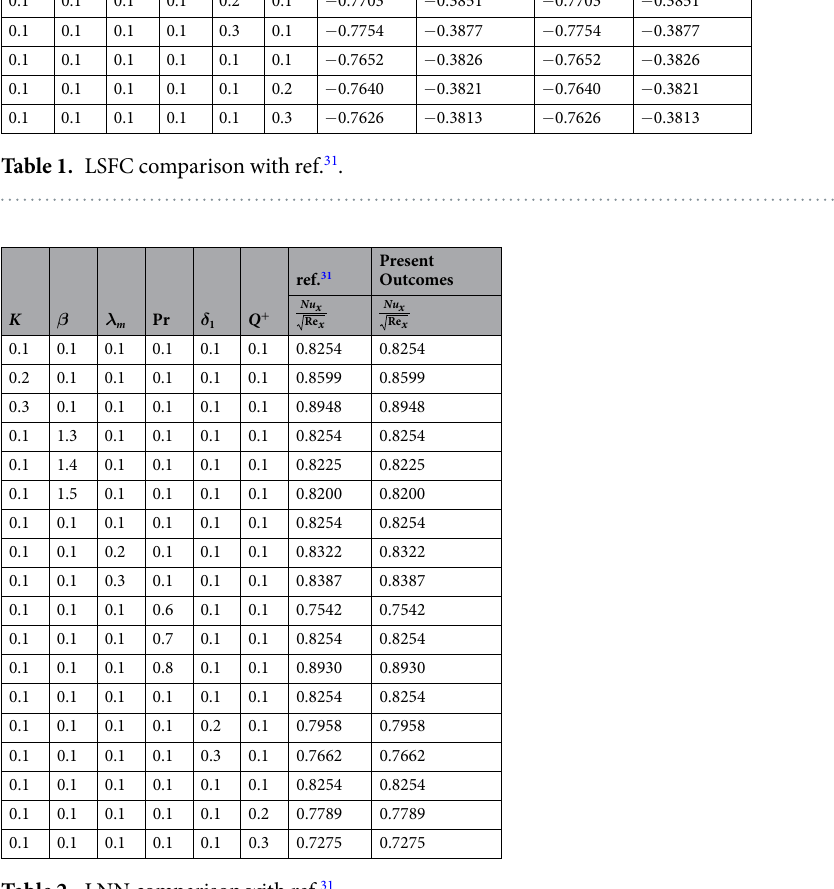
Table 2. LNN comparison with ref. 31 .